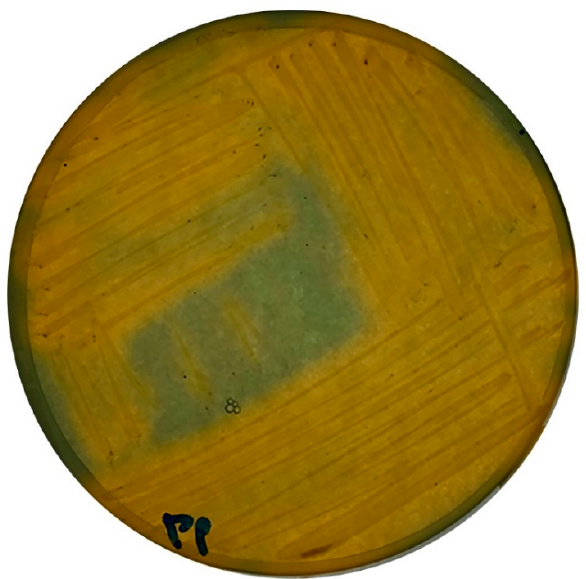
Figure 4. CAS Agar Plate with Pseudomonas putida mt2 illustrating the production of Siderophores (orange colouration of siderophores complexes).